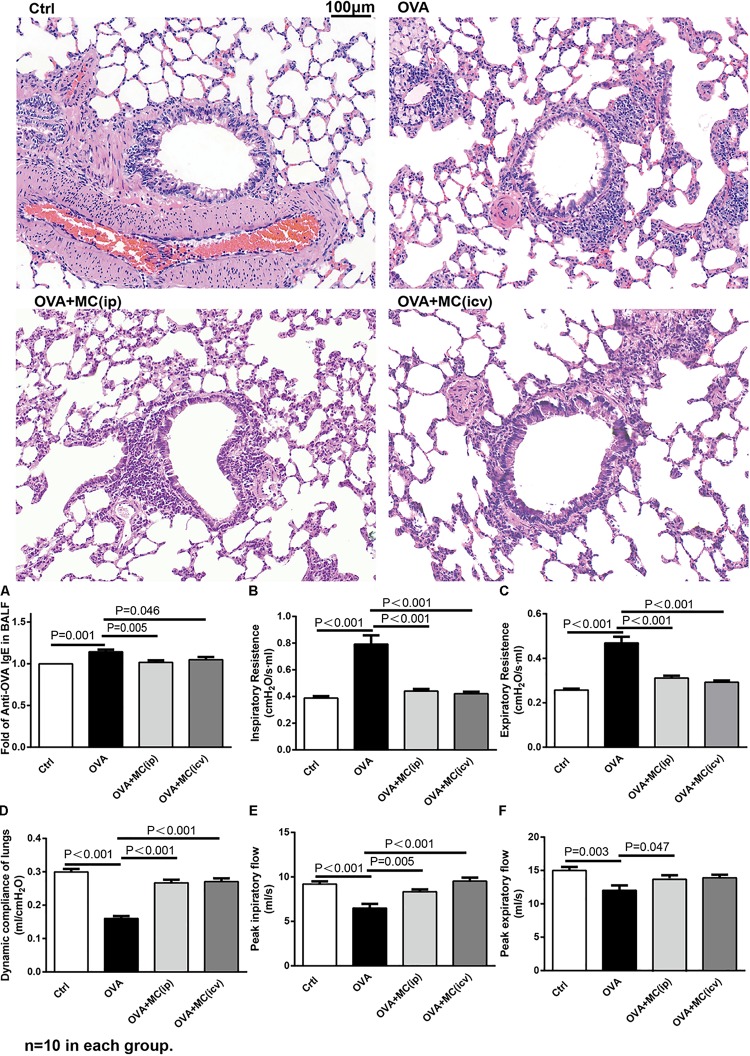
Experimental airway allergy decreased pulmonary function and induced pulmonary inflammation, and all of which were attenuated by intraperitoneal or intracerebroventricular minocycline treatment. The photos on upper panels are H&E staining of lung tissues in control, OVA, OVA + MC(ip) and OVA + MC(icv) groups (examined in ten rats in each group), showing the infiltration of inflammatory cells in rats of OVA group and the alleviation by minocycline in rats of OVA + MC(ip) and OVA + MC(icv) groups. (A–F) Bar graphs for the relative concentration of OVA-specific IgE in BALF, inspiratory resistance of the airway (Ri), expiratory resistance of the airway (Re), dynamic compliance of the lungs (Cdyn), peak inspiratory flow (PIF) and peak expiratory flow (PEF) in rats of control, OVA, OVA + MC(ip) and OVA + MC(icv) groups (n = 10 in each group), showing the changes in rats OVA group and the attenuation of the changes by minocycline in rats of OVA + MC(ip) and OVA + MC(icv) groups. P-values were obtained from one-way ANOVA followed by Tukey correction.